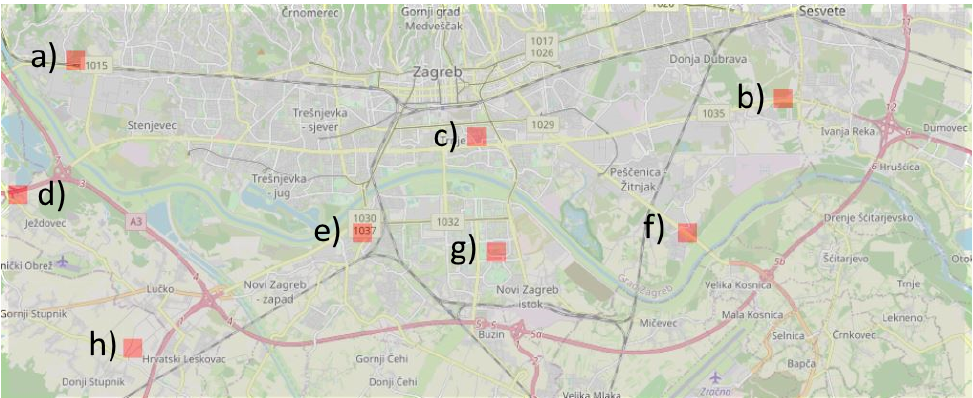
Figure 9. Positions of the anomalous cells on the map ( a – h ) represent most anomalous parts of the traffic network in the City of Zagreb.